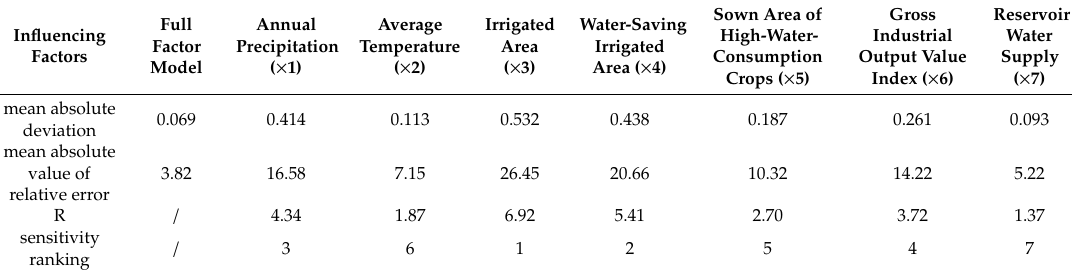
Table 1. Sensitivity of groundwater level to the influencing factors with default test method.